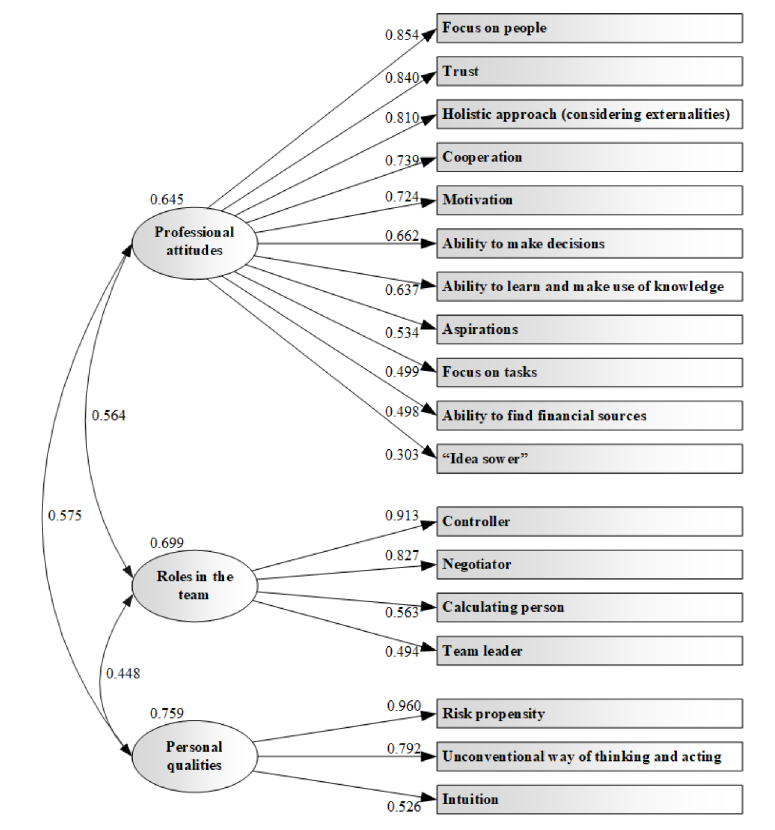
Figure 1. Women’s participation model in the innovation process (source: Author’s work, with Amos